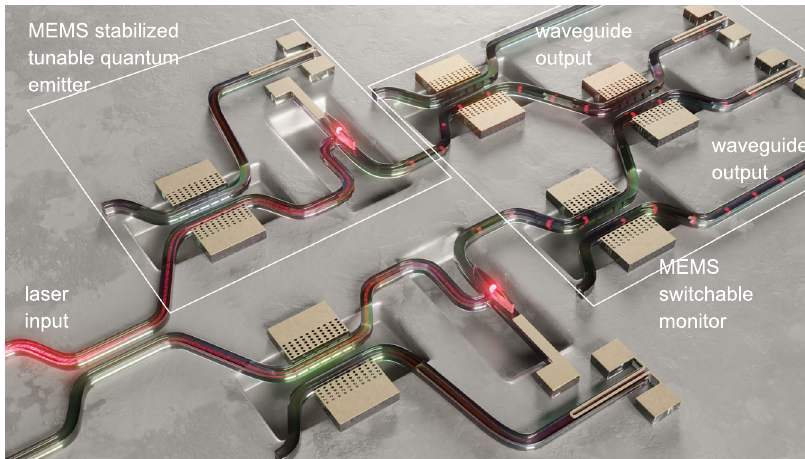
Fig. 4 Near-term application of our technology. Example of a monitored and stabilized on-chip photon source as a near-term application of our technology. The device includes two power stabilizers connected to two MEMS-tunable quantum emitters and MEMS splitters for switching into an HBT/HOM monitoring